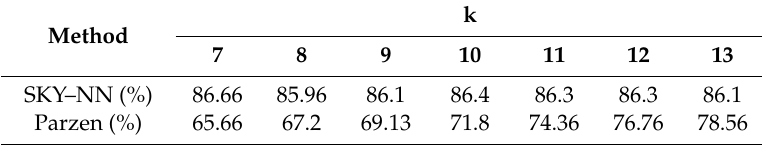
Table 25. Double skyline on the real dataset.